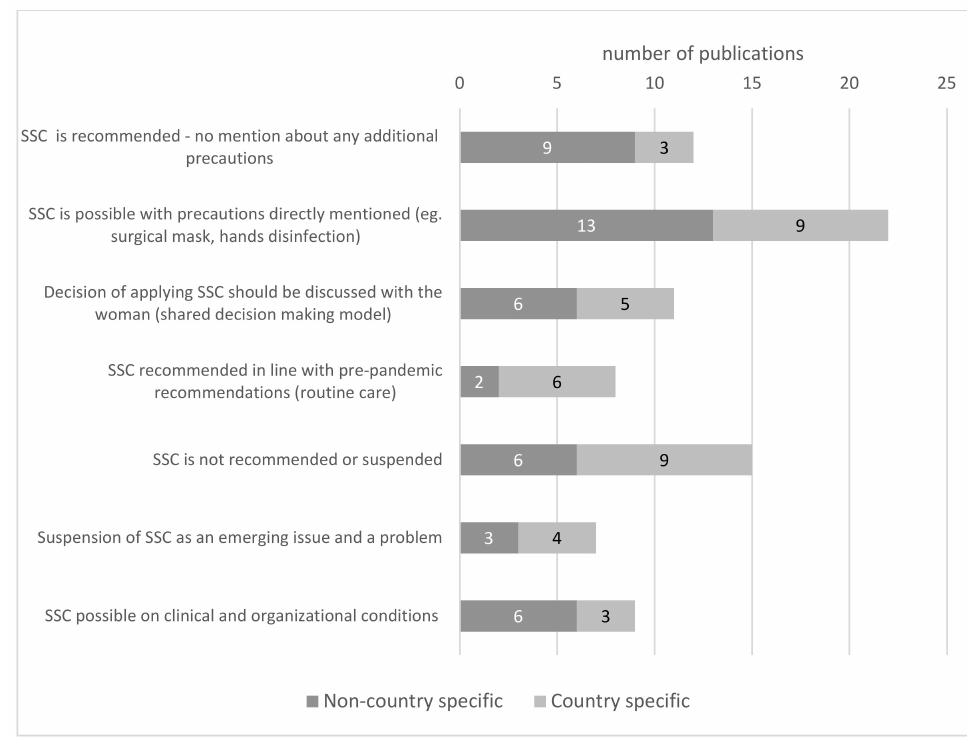
Figure 4. Recommendations concerning skin-to-skin (SSC) contact for mothers with confirmed and/or suspected